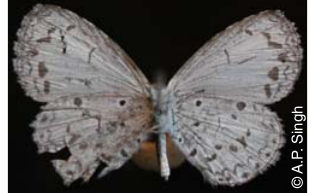
(under)Image 21. Common Hedge Blue, Acytolepis puspa